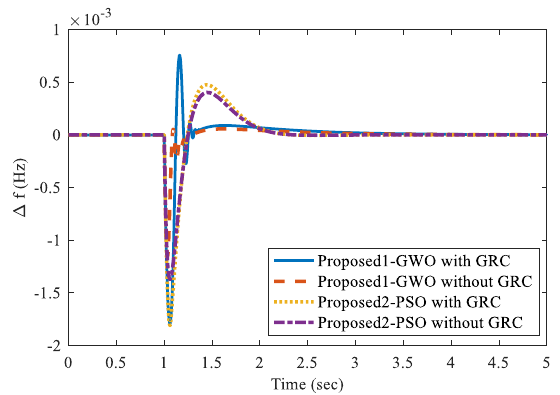
Fig. 8 Frequency regulation of SAPS with